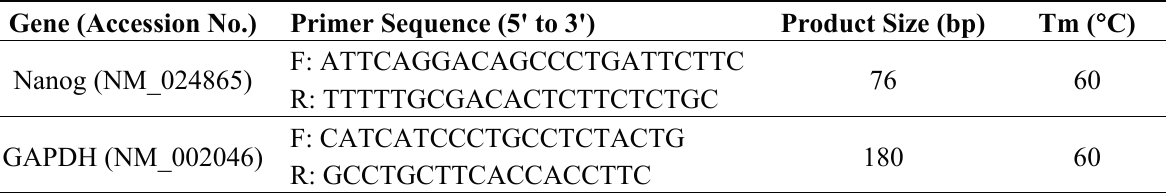
Table 1. The sequences of the primers for quantitative